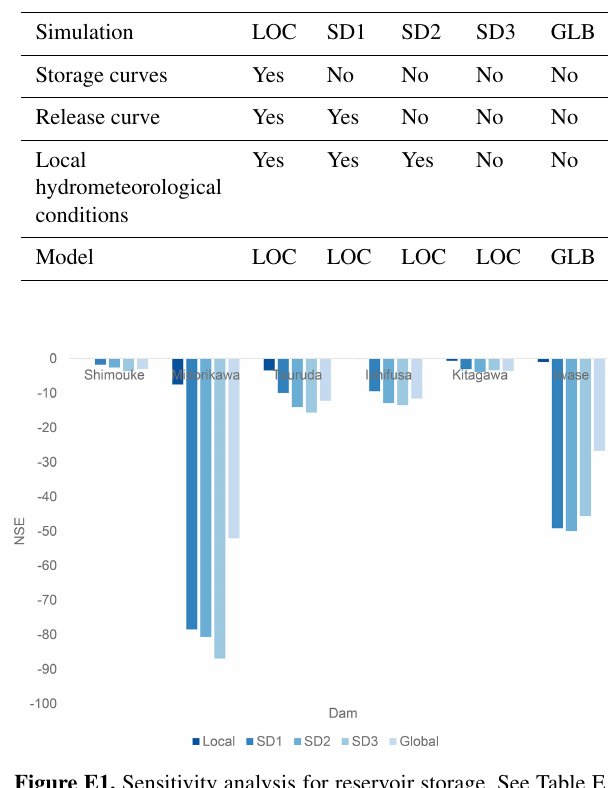
Table E1. Sensitivity simulation on reservoir operation.